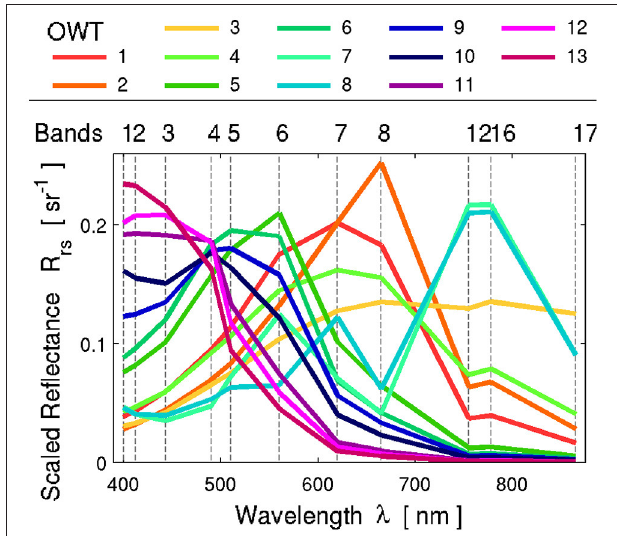
FIGURE 3 | Brightness-scaled remote sensing reflectances for 13 classes of optical water types. Utilized OLCI bands are